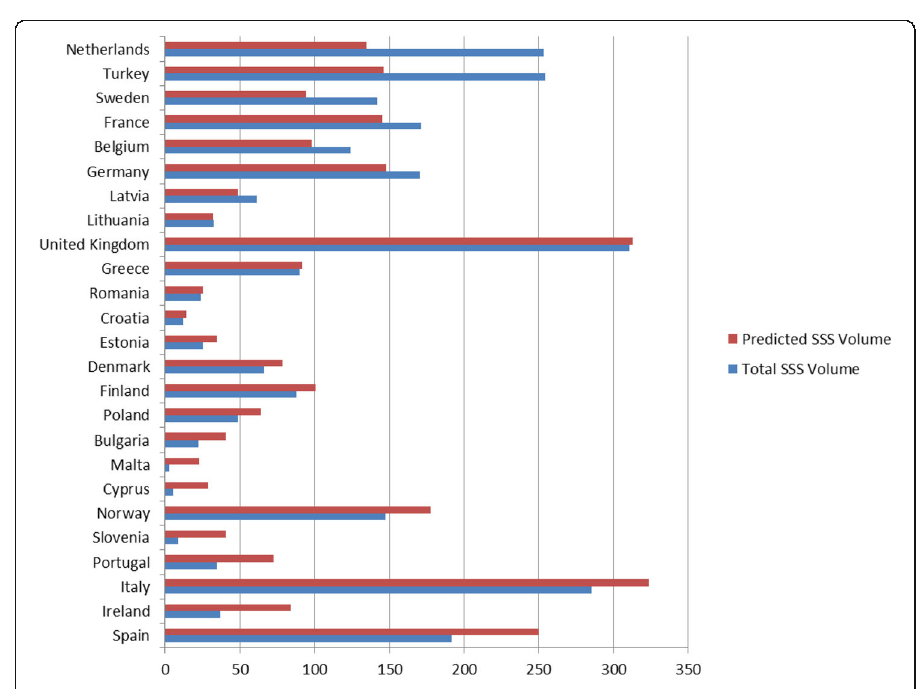
Fig. 2 Predicted and actual SSS volumes per